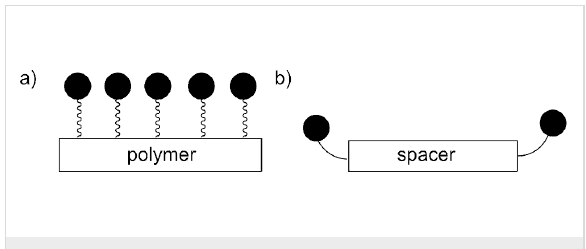
Figure 1: Schematic depiction of (a) a rigid phenylene-ethynylene polymer core with ligands attached via flexible chains, and (b) a diva- lent ligand using phenylene-ethynylene as a rigid spacer connecting the ligands.